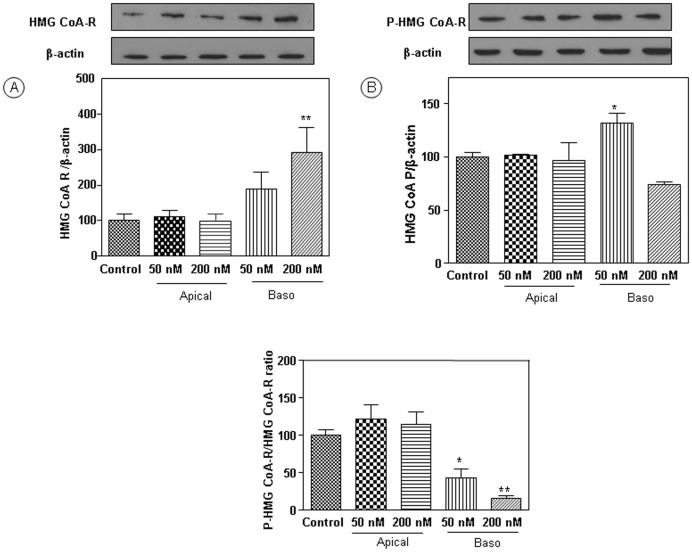
Effects of the administration of PYY (1–36) to the apical or basolateral medium on the protein expression of HMG-CoA-R (A) and phosphorylated HMG-CoA-R (B).Caco-2/15 cells were cultured for 24 h in MEM as described in Figure 2. Western blot was used to analyze the protein expression and phosphorylation of HMG-CoA-R. Values are means ± SD for n = 3 separate experiments in each group and are reported as % of control values representing 100%. *P<0.05 vs. controls, ** P<0.01 vs. controls.